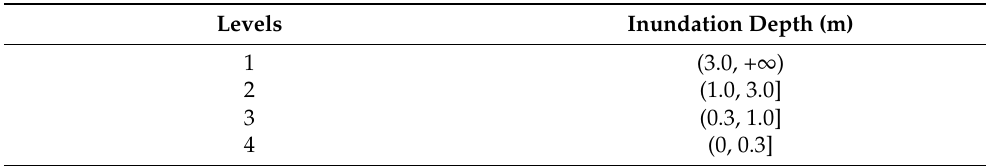
Table 3. Classification of tsunami